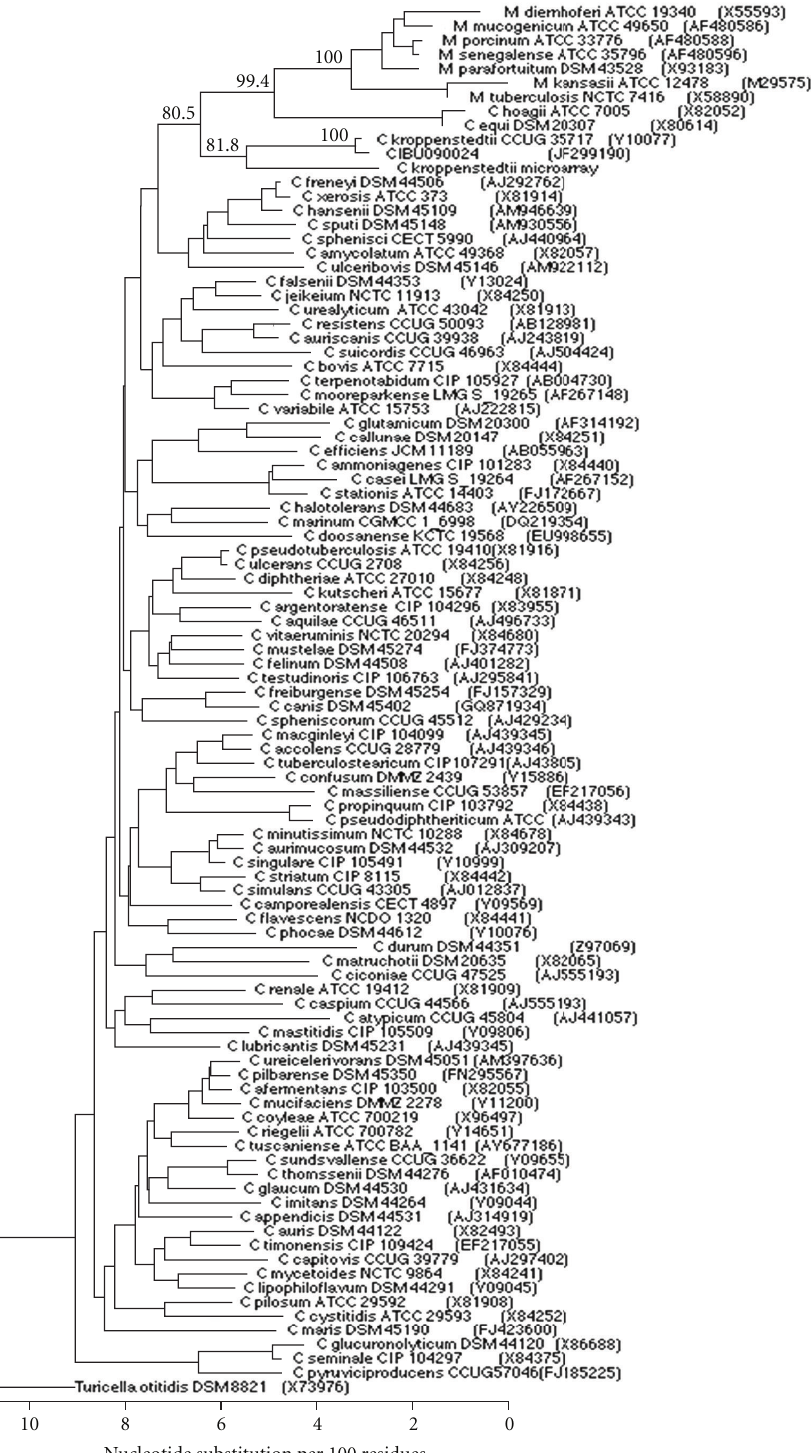
Figure 1: Phylogenetic tree based on 16S rRNA gene sequences of isolate CIBU090024 and representative Corynebacterium and Mycobac- terium species, constructed using the neighbour-joining method. Bootstrap values > 50% (based on 1000 replicates) are given at branching points. GenBank accession numbers are given in parentheses. All sequences come from type strains. Turicella otitidis DSM 8821 T was used as an